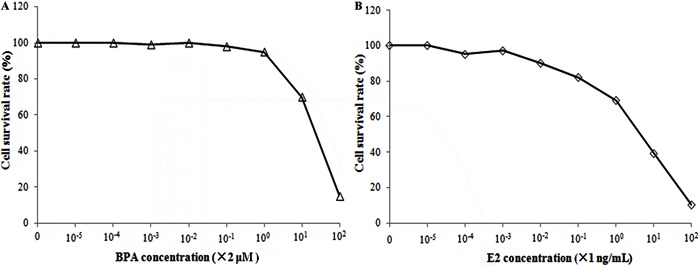
Inhibitory effect of bisphenol A (BPA) and estradiol (E2) on normal liver
cell survival. The inhibitory action was stronger with increased dosage of BPA
and E2.